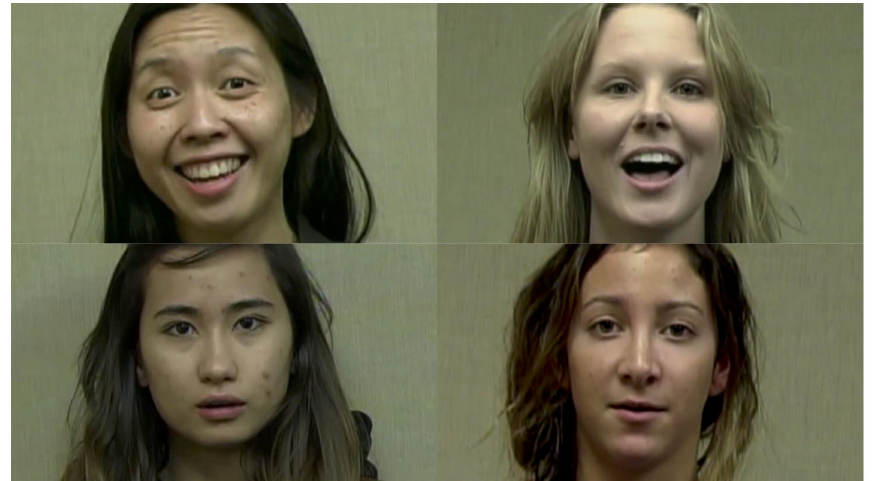
Figure 1. Screenshots from four of the stimulus movies used in this study. On the top row, the women are using infant-directed speech, and on the bottom row the women are using adult-directed speech. The women on the left are Asian American, and the women on the right are